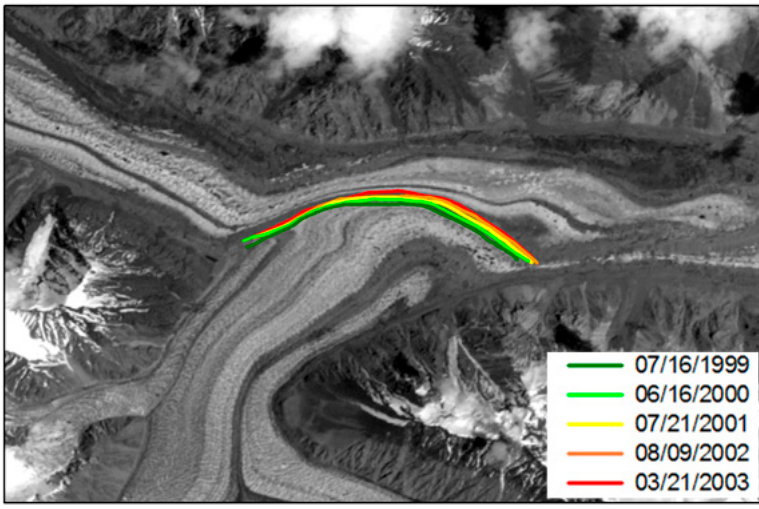
Figure 9. The frontal changes of the South Skamri Glacier from 1999 to 2003, the background is the Landsat ETM+ image acquired on 16 July 1999.